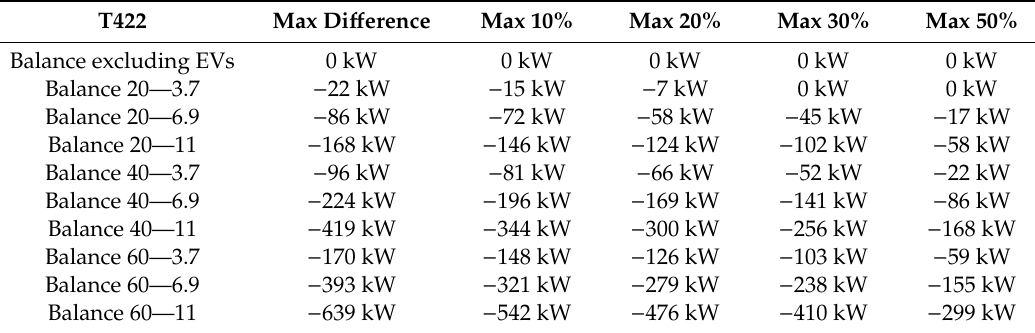
Table 8. E ff ect of flexible demand for Transformer